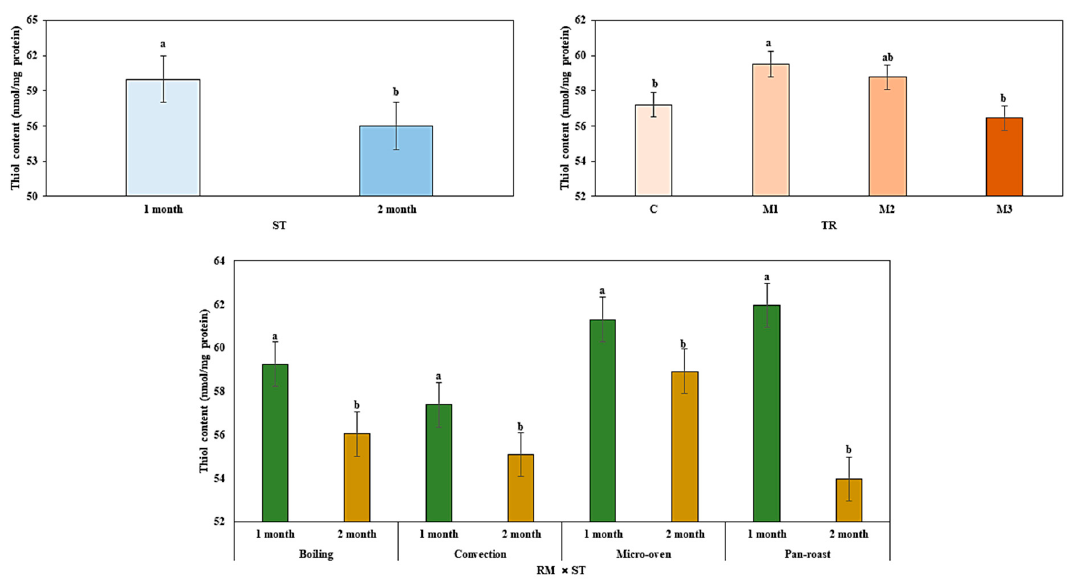
Figure 4. Effect of different reheating condition on thiol content of nutmeg extract enriched precooked beef meatballs during frozen storage. RM, reheating method; ST, storage time; C, antioxidant-free meatballs; M1, 0.02% BHT treated; M2, 0.02% nutmeg extract treated; M3, 0.02% nutmeg powder treated. a-b Means with different superscript small letters differ significantly ( p < 0.05) in thiol content among treatments at different reheating method within 1 and 2 months independently.